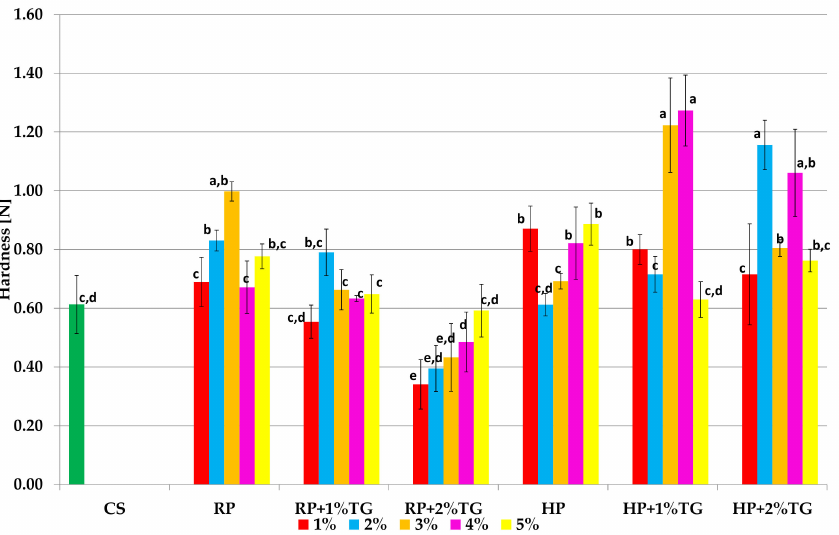
Figure 6. Average hardness values of hydrated instant noodles with the addition of rice protein, hemp protein and TGase (CS—control sample, RP—rice protein, RP+1%TG—rice protein with 1% TGase, RP+2%TG—rice protein with 2% TGase, HP—hemp protein, HP+1%TG—hemp protein with 1% TGase, HP+2%TG—hemp protein with 2% TGase). Columns correspond to various additions of rice protein. Mean values denoted by different letters ( a – e ) represents statistically significant differences between variables ( p <